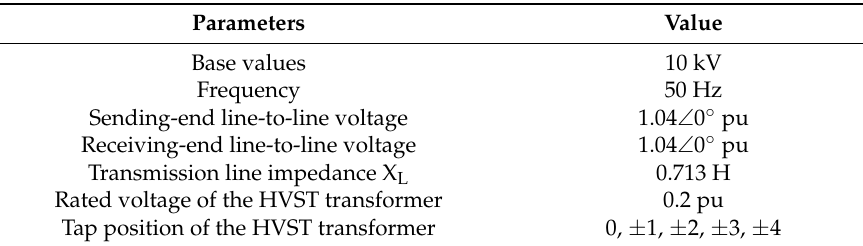
Table 5. Experiment parameters for the HVST.